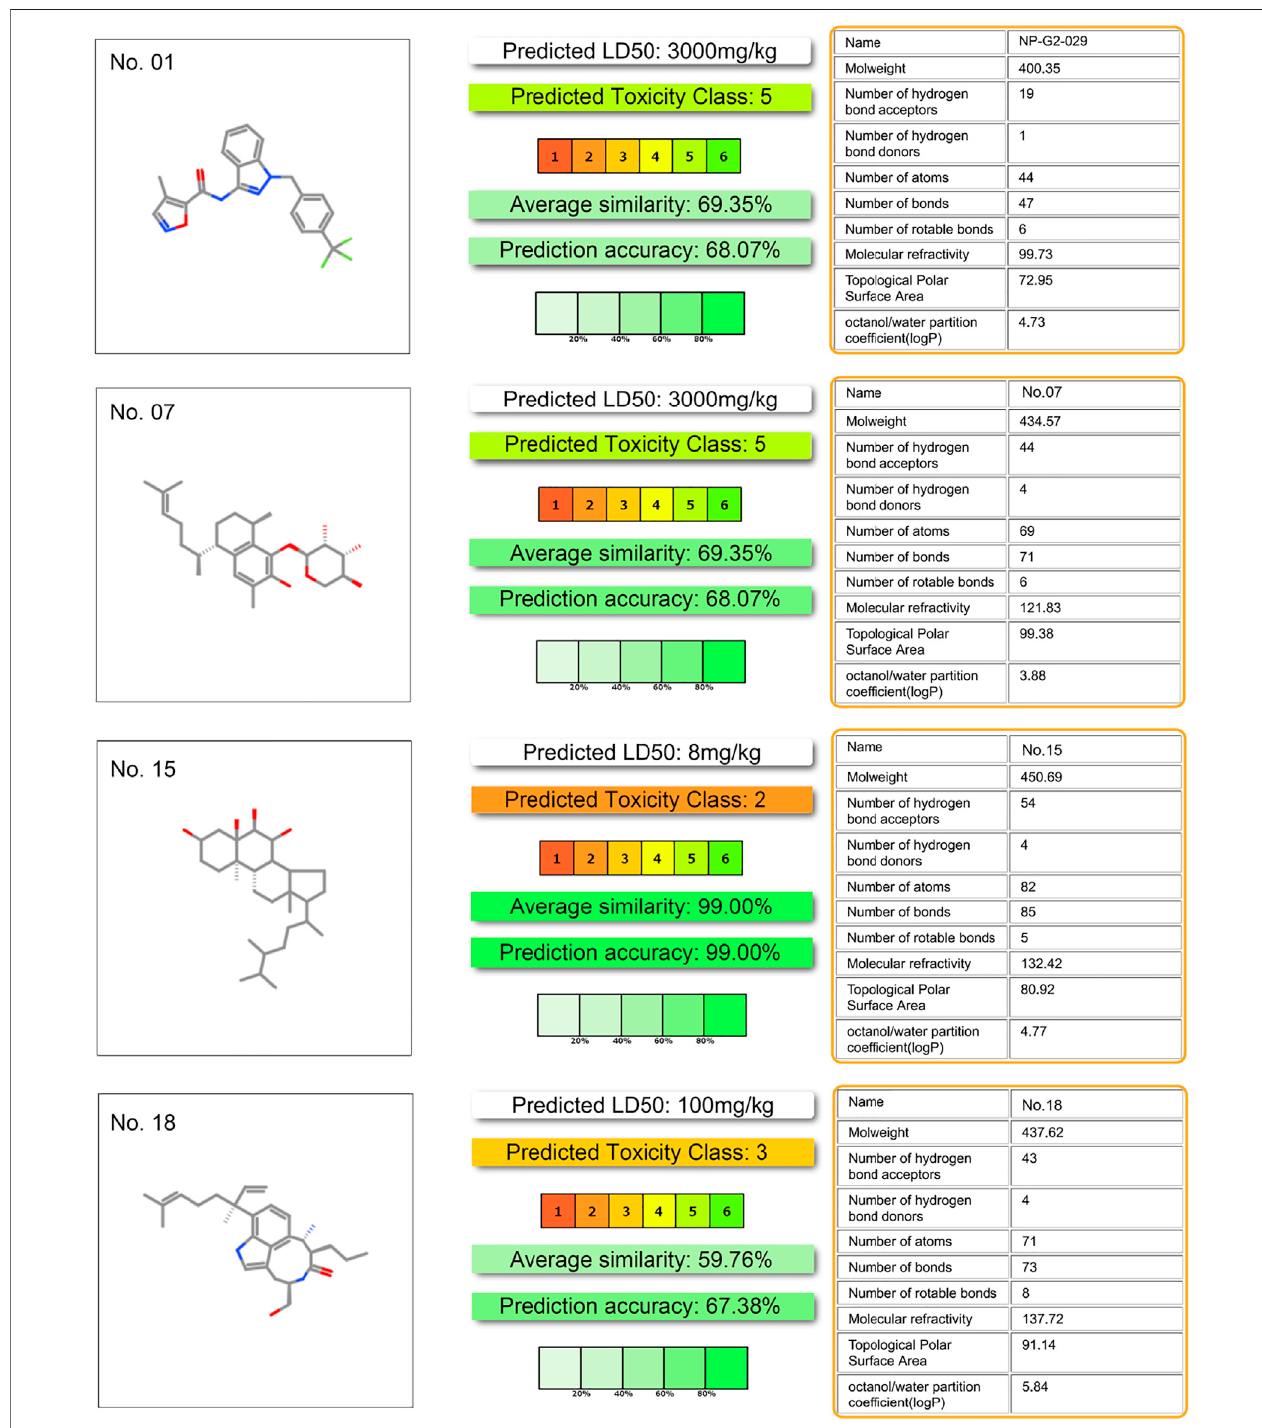
FIGURE 7 | Toxicity evaluation result. Evaluation processed by ProTox-II server (https://tox-new.charite.de/) (Banerjee et al., 2018).